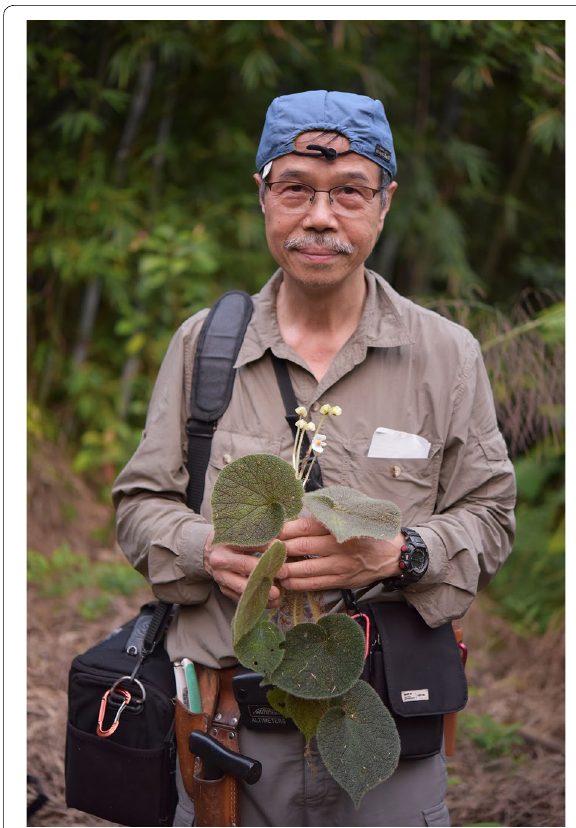
Fig. 1 Ching‑I Peng, holding Begonia aurora C.I Peng, Yan Liu & W.B.Xu. Photograph taken on April 18,